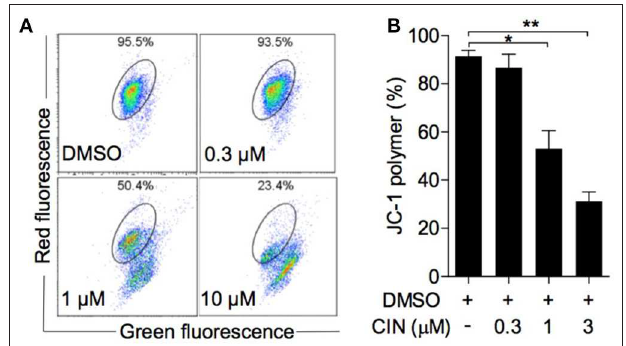
FIGURE 5 | Cinobufagin reduced the mitochondrial membrane potential (MMP) of OCM1 cells. (A) OCM1 cells were treated with cinobufagin at 0, 0.3, 1, and 10 µ M for 24h. Then, OCM1 cells were stained with JC-1, and the change in MMP was measured by flow cytometry. (B) The percentage of aggregated JC-1 was quantified using GraphPad. The results are shown as the mean ± SEM of three independent experiments [* P < 0.05 and ** P < 0.01 compared with the DMSO